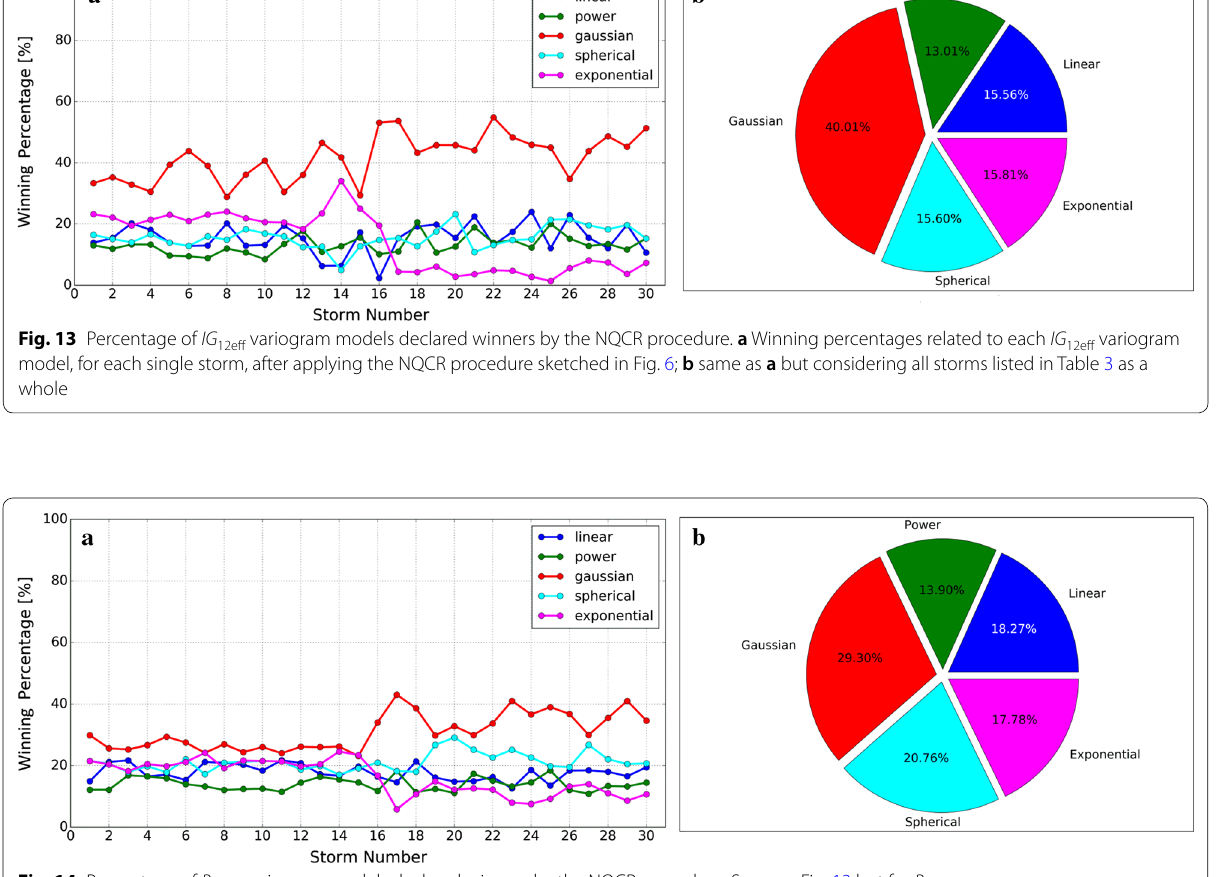
Fig. 14 Percentage of R 12eff variogram models declared winners by the NQCR procedure. Same as Fig. 13 but for R